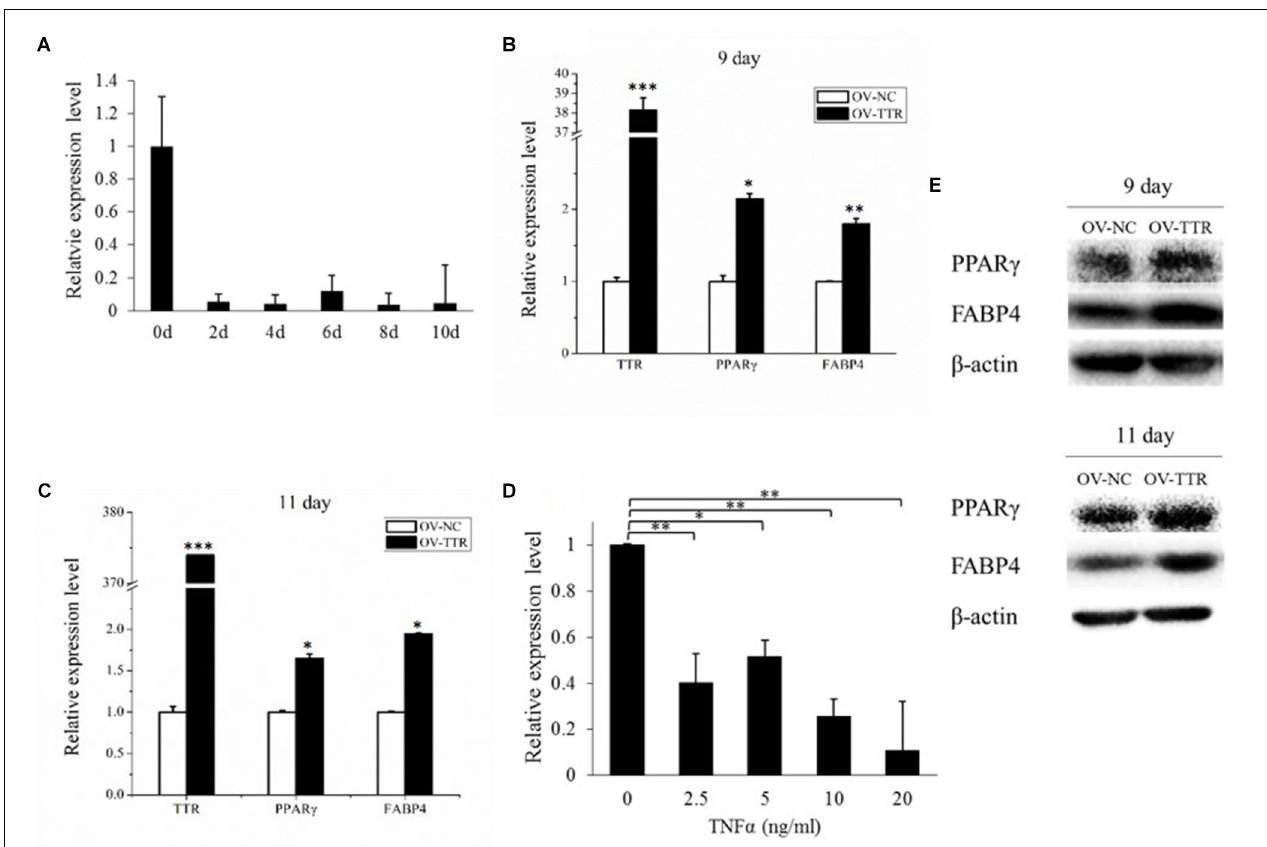
FIGURE 7 | TTR is involved in bovine adipogenic differentiation. (A) The expression of TTR during bovine adipocyte differentiation. (B) On 9th day, overexpression of TTR increased mRNA expression of PPAR γ and FABP4. (C) On 11th day, overexpression of TTR increased mRNA expression of PPAR γ and FABP4. (D) TNF α treatment down regulate the expression of TTR. (E) TTR overexpression also promote protein expression of PPAR γ and FABP4. Each treatment is in triplicate. OV-TTR: overexpression vector of bovine TTR gene. OV-NC: empty pcDNA3.1 (+) plasmid without any insertion fragment. ∗ P < 0.05. ∗∗ P < 0.01. ∗∗∗ P <